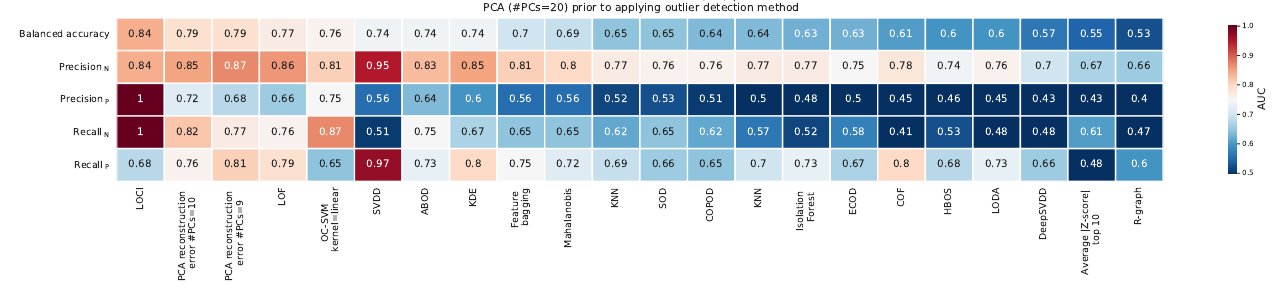
Figure A3. Evaluation metrics at the ‘closest-to-(0,1)’ point for four methods as indicated on the x-axis when 20 PCs are used to transform the